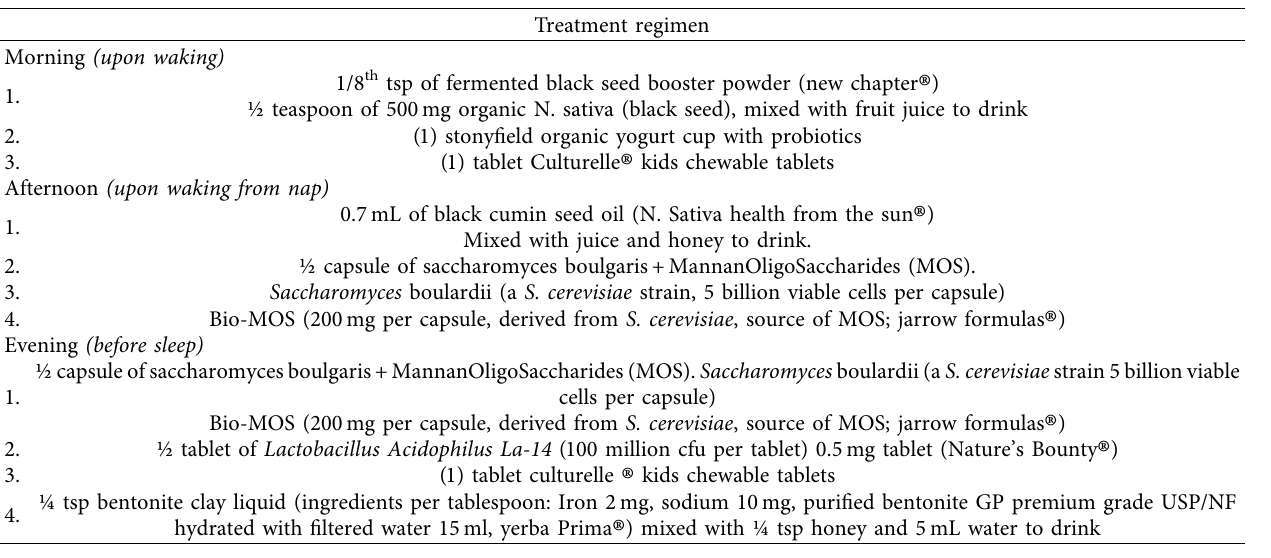
Table 1: Treatment regimen for two-year-old